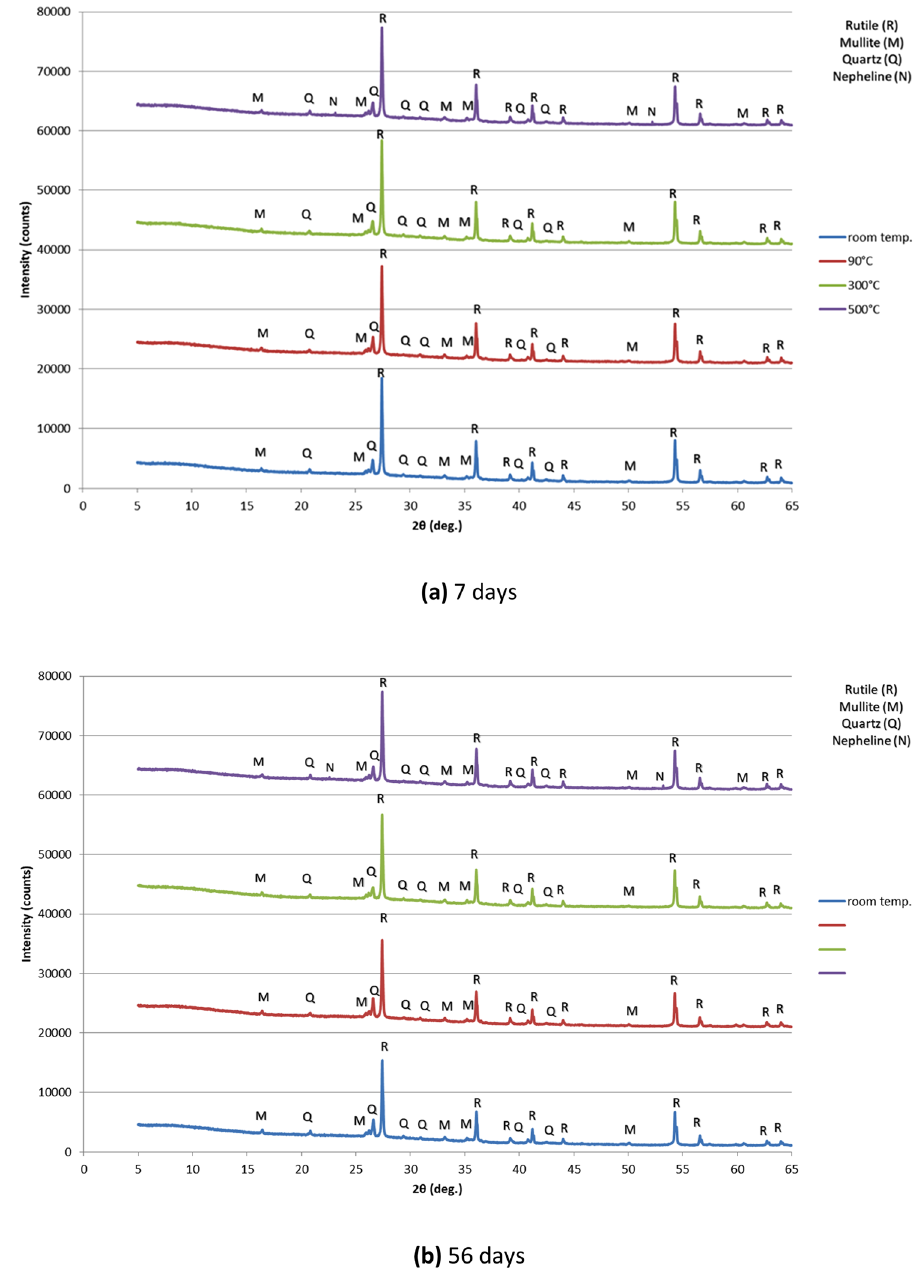
Fig. 8 X-ray patterns of MK9_20 at different tempera- tures at ages of a 7 days and b 56